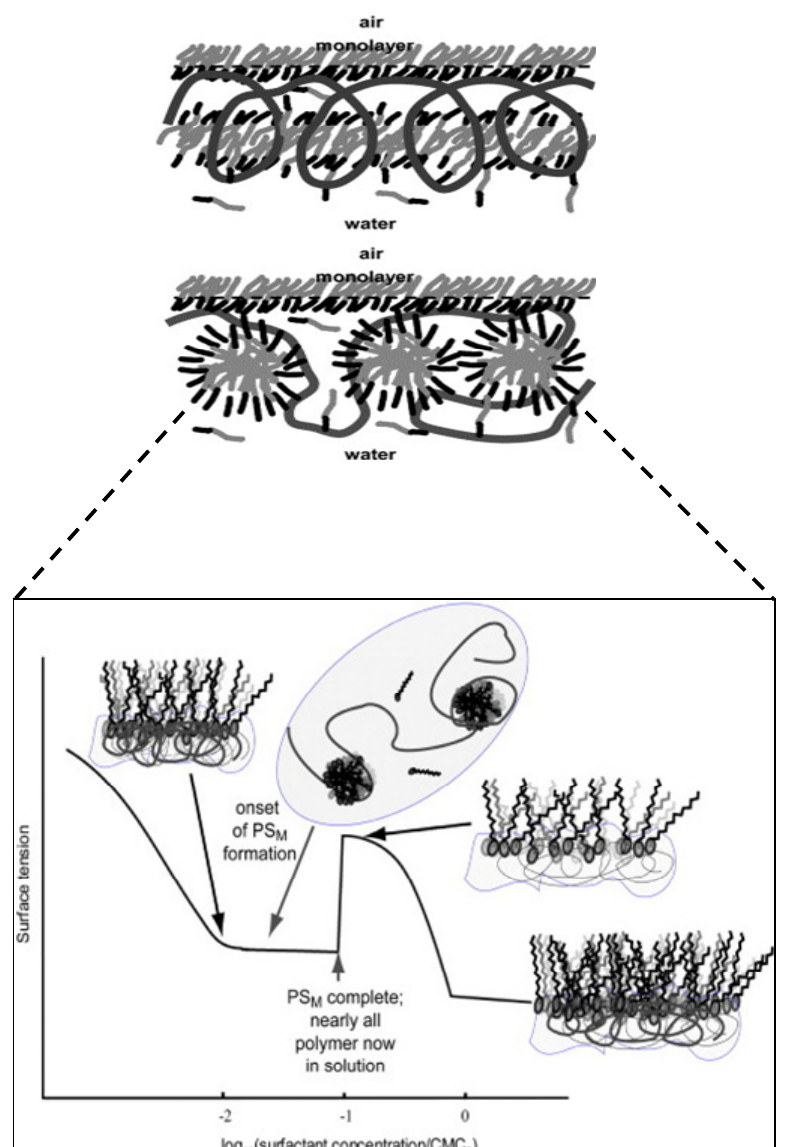
Figure 4. Schematic of potential structure of polymer-surfactant combination in solution and the resultant reduction in surface tension of the solution as a function of surfactant concentration (Adopted from Taylor and Penfold,